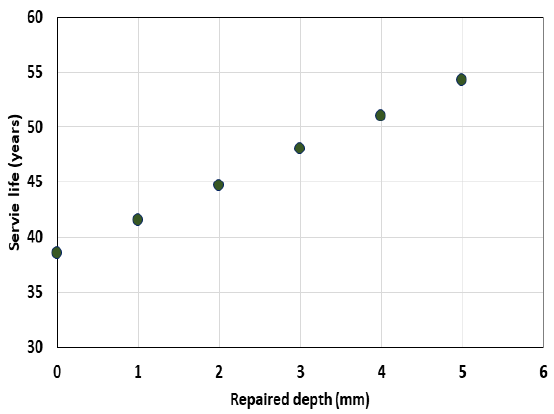
Figure 7. Service life variation with coating thickness. 220